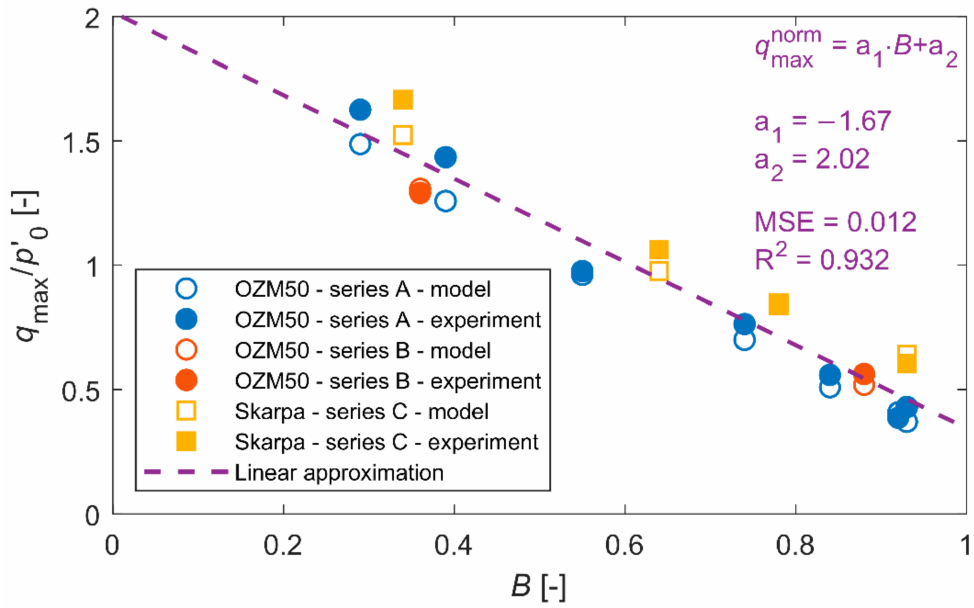
Figure 25. Linear changes of normalized maximum stress deviator with Skempton’s parameter B